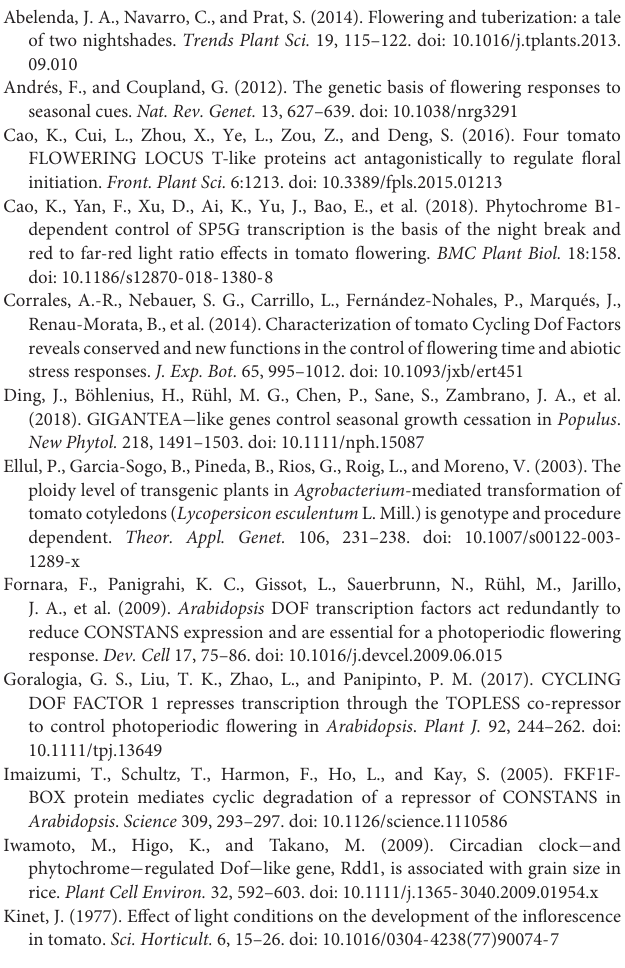
Supplementary Figure 2 | Transcription analyses of tomato SlCDF1–5 in response to day-neutral (DN) conditions. SlCDF1–5 expression levels were assayed by qRT-PCR in 4-weeks-old tomato plants grown under a diurnal cycle of 12 h light/12 h dark. White and black bars along the horizontal axis represent light and dark periods, respectively. Three technical replicates were performed for each extract, vertical bars on the lines represent the SE ( n = 3). Supplementary Figure 3 | Transcription analyses of target genes in SlCDF1–5 -overexpressing tomato plants. SlCDF1 (A) , SlCDF2 (B) , SlCDF3 (C) , SlCDF4 (D) , and SlCDF5 (E) expression assayed by qRT-PCR in T0 generation transgenic tomatoes grown under day-neutral (DN) conditions. Three technical replicates were performed for each extract, vertical bars on the lines represent the SE ( n = 3). Supplementary Figure 4 | Overexpression of SlCDF1 , SlCDF2 , SlCDF4 , and SlCDF5 had no effect on flowering time of tomato under long day (LD) and short-day (SD) conditions. (A) Images of overexpression tomato plants flowering under LD and SD conditions. The red circles indicate flowers. (B) Leaf number at flowering in overexpression tomato plants under LD and SD conditions. Vertical bars on the lines represent the SE ( n = 6). Supplementary Figure 5 | Overexpression of SlCDF1 , SlCDF2 , SlCDF4 , and SlCDF5 did not change the transcription of SlSP5G under long day (LD) conditions. Three technical replicates were performed for each extract, vertical bars on the lines represent the SE ( n =